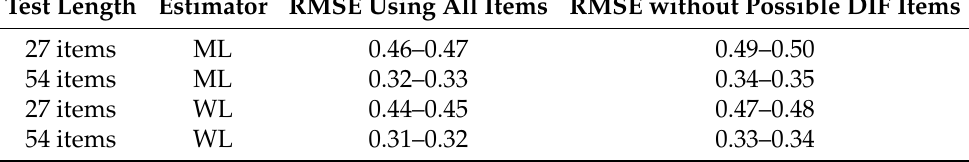
Table 1. The range of median RMSEs for the person parameter estimation for all conditions without DIF